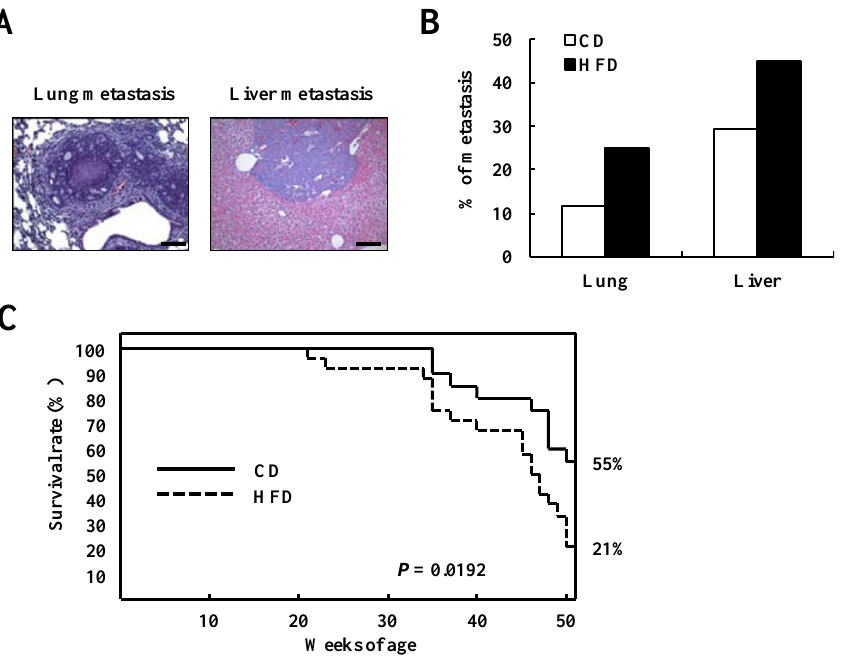
Figure 4. HFD feeding reduces the survival rate in TRAMP mice. ( A , B ) TRAMP mice were fed a CD (17 mice) or HFD (20 mice) for a period of 28 weeks. Mice were sacrificed